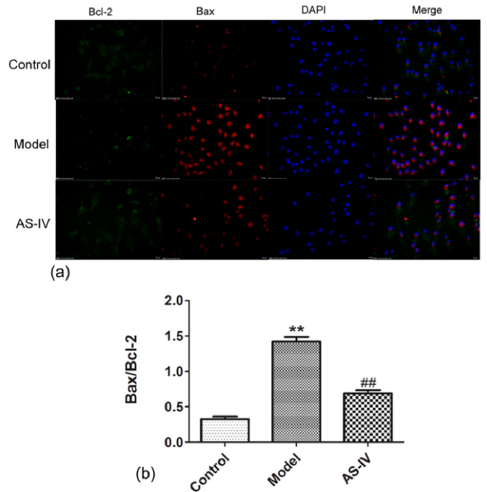
Figure 5. Astragaloside IV reduced Bax / Bcl-2 in HT22 cells after OGD / R immunofluorescence staining for Bax and Bcl-2 of HT22 cells after OGD / R (means ± SD, n = 3. ** p < 0.01 vs. control and ## p < 0.01 vs. model). (scale bar = 20 µ m) Fluorescent images: Green, Bcl-2; red, Bax; and blue,